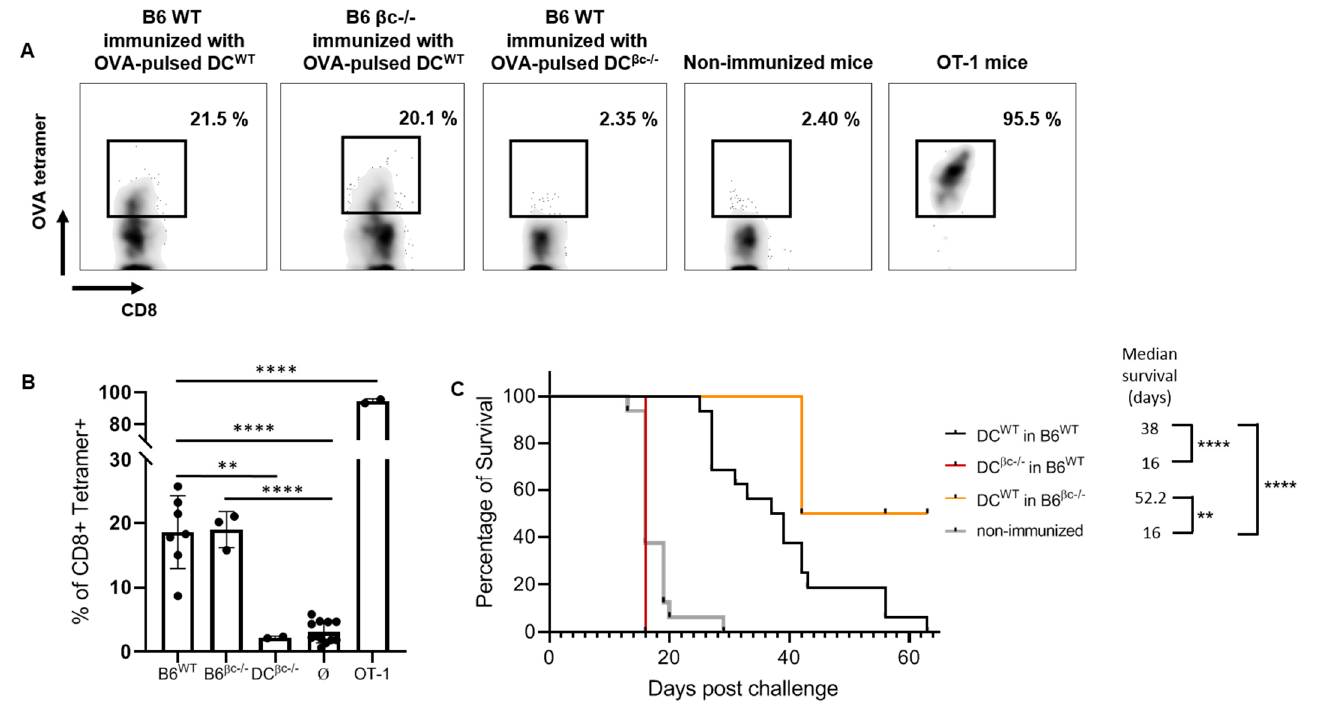
Figure 4. The lack of a specific immune response to prevent tumor growth in the absence of functional GM-CSF signaling is rescued with OVA-pulsed DC WT . DC WT or DC β c-/- were pulsed with OVA peptide and injected in C57BL/6 WT or β c-/- mice. After five days, PBL were isolated from blood punction and analyzed by flow cytometry for OVA-specific CD8 + T cells. ( A ) Representative dot plot of staining for OVA-specific CD8 + T cells tetramer. ( B ) Histograms of the percentage of OVA-specific CD8 + T cells in the peripheral blood of non-immunized mice ( n = 12), OT-1 positive mice ( n = 2) or B6 WT mice immunized with OVA-pulsed DC WT ( n = 7) or OVA-pulsed DC β c-/- ( n = 2), or B6 β c-/- mice immunized with OVA-pulsed DC WT ( n = 3). ( C ) C57BL/6 WT mice were immunized with OVA-pulsed DC WT ( n = 16) or OVA-pulsed DC β c-/- ( n = 2), and C57BL/6 β c-/- mice were immunized with OVA-pulsed DC WT ( n = 3). Non-immunized B6 WT mice were used as the negative control ( n = 16). Seven days later, the mice were then challenged with a contro-lateral s.c. injection of live B16-OVA tumor cells. Following the injection, the mice were monitored for survival and were sacrificed when tumors ulcerated or reached 10 mm in diameter. The survival of the animals was plotted as a Kaplan–Meier curve for each group and analyzed by the log rank-survival test. Differences regarded as statistically significant between the groups are presented as fol-lows: * p < 0.05, ** p < 0.01, *** p < 0.001 and **** p < 0.0001.